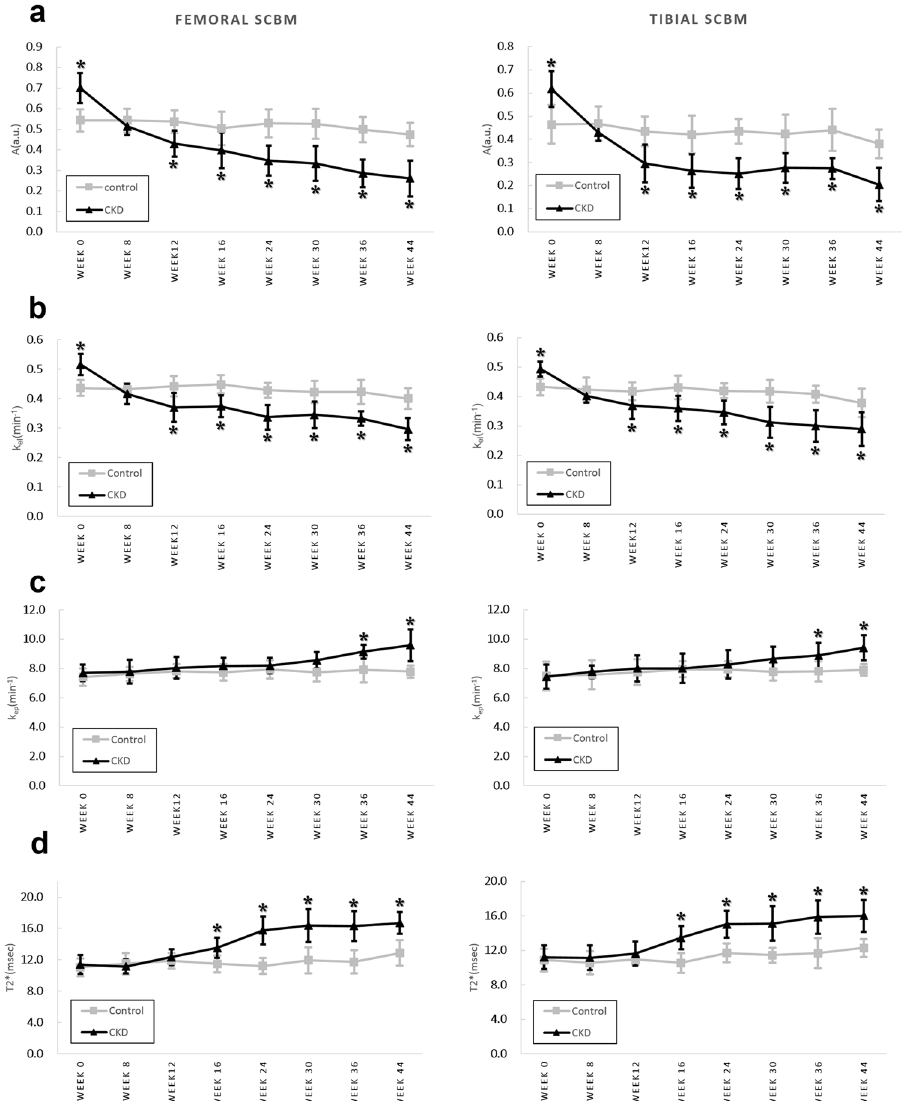
for the femoral and tibial subchondral bone marrow (SCBM) of the control and CKD groups. ( a ) Amplitude A (unit: au). ( b ) Elimination constant k el (unit: min − 1 ). ( c ) Permeability rate constant k ep (unit: min − 1 ). ( d ) T2 * (unit: msec). All values were measured in the right knees of all rats. Asterisks demonstrated significant differences (p < 0.05). A significant increase in the blood volume parameter A and washout parameter k el can be observed in ( a ) and ( b ) at week 0, and was followed by a decrease beginning at week 8. Significant increases can be noted in the permeability rate constant k ep ( c ) starting from week 36 and in MRI T2 * value (i.e., edematous change) ( d ) starting from week